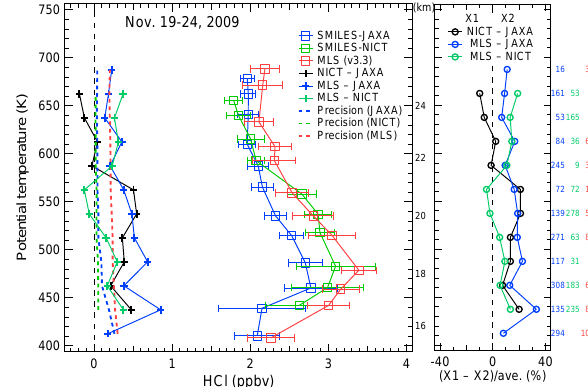
-40 0 40 (X1 – X2)/ave. (%)